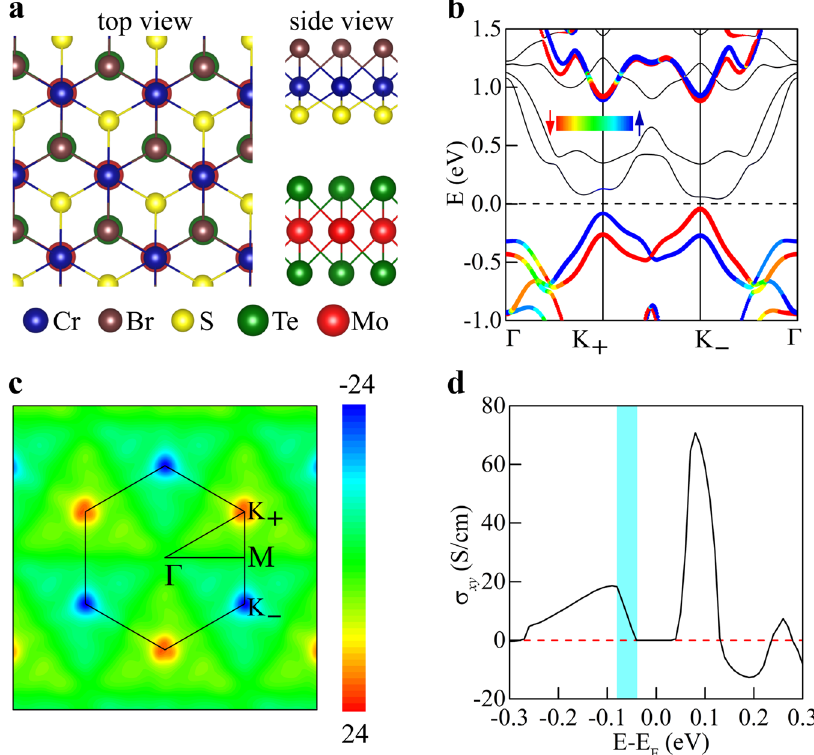
Fig. 4 Electronic and topological properties of CrSBr/MoTe 2 . a Top and side views of the stable stacking con fi guration. b MoTe 2 -projected (colored lines) band structure. Color bar indicates the spin projections. c Distribution of Berry curvature (in unit of Å 2 ) over 2D Brillouin zone. d Dependence of σ xy on the Fermi level. The shaded area denotes the energy window between the two valence-band valley